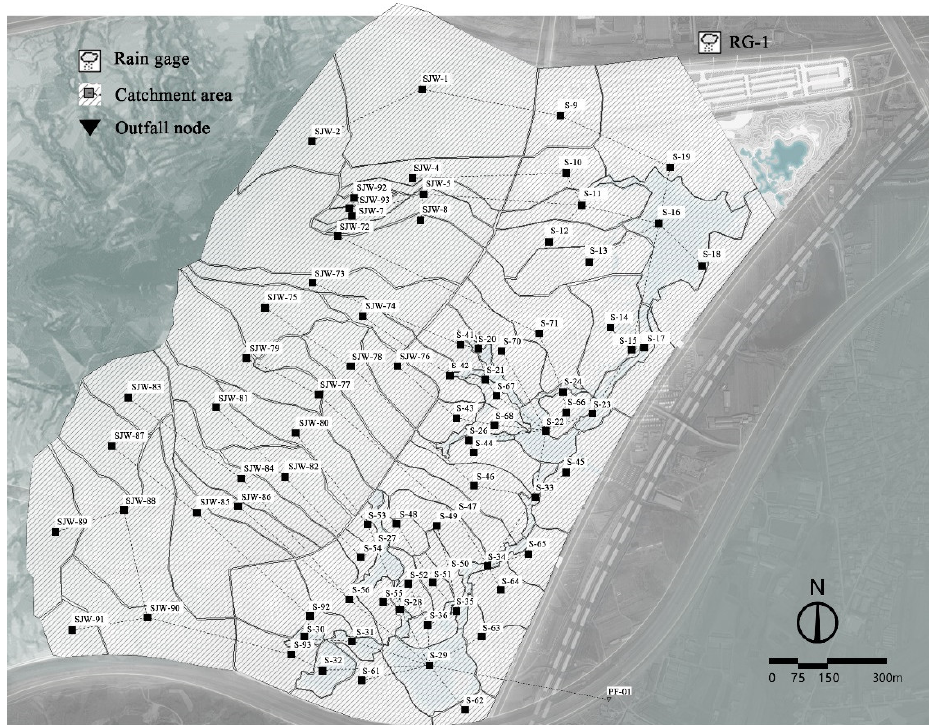
Figure 5. Subdivision map of site catchment area after